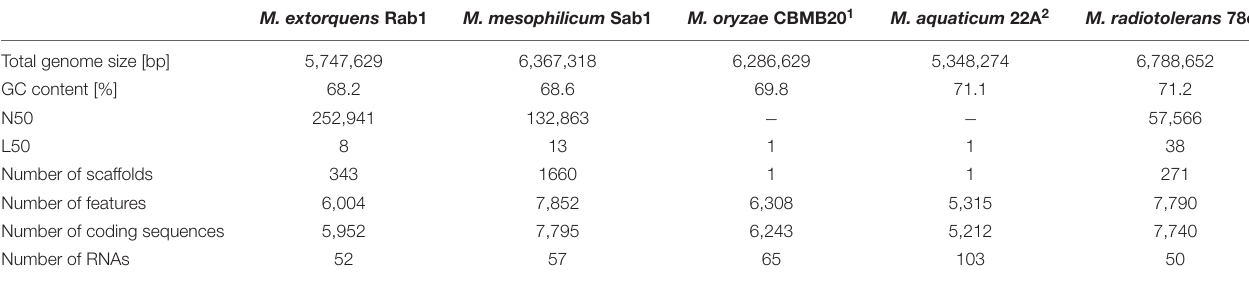
TABLE 1 | Detailed genome statistics for the analyzed Methylobacterium isolates.